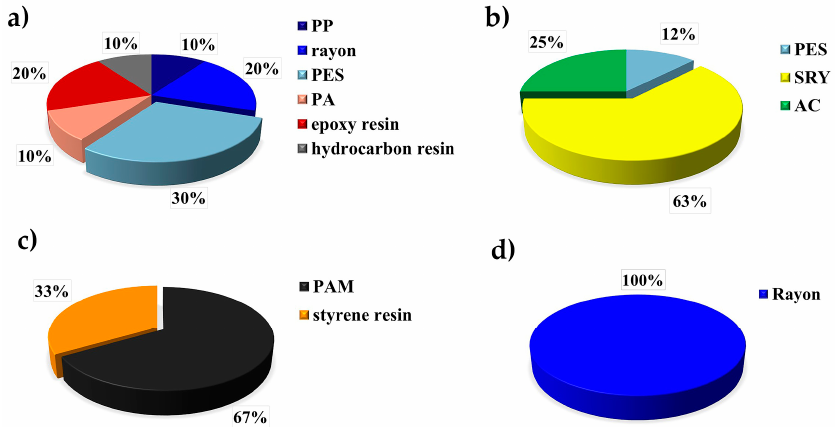
Figure 6. The percentages of different compositions of MPs in the AS, Antarctica: ( a ) family Noto- theniidae; ( b ) family Channichthyidae; ( c ) family Artedidraconidae; ( d ) family Zoarcidae.